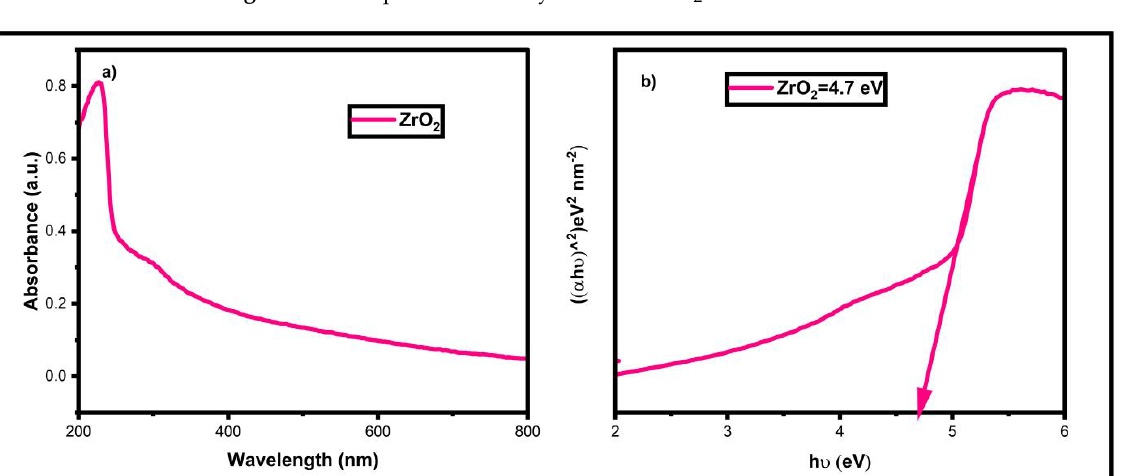
Figure 3. UV-DRS absorbance spectrum ( a ) and bandgap plot ( b ) of biosynthesized ZrO 2 NPs.